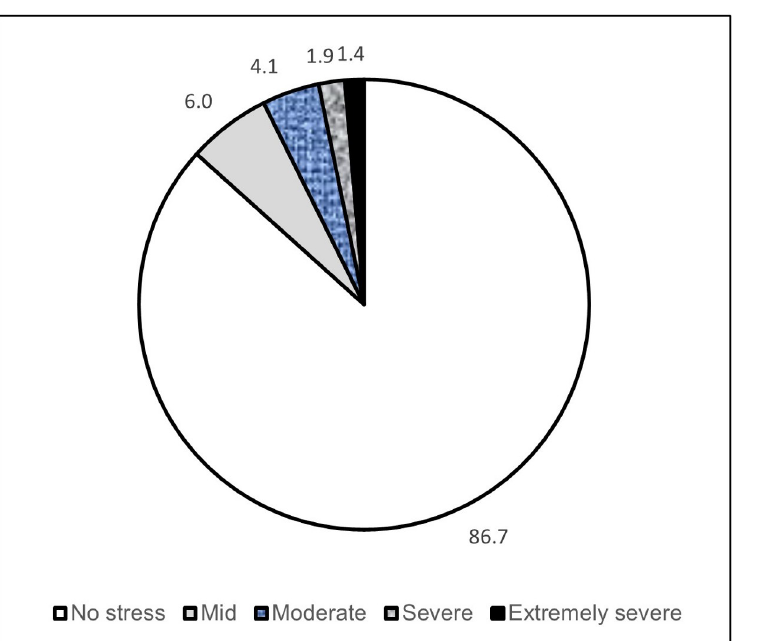
Fig 1. Level of stress among waste collectors in this study (N =